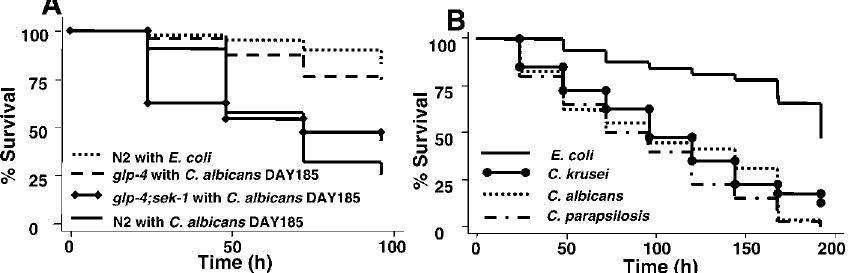
Figure 1. Killing of C. elegans after Exposure to Candida Species (A) N2, glp-4, or glp-4;sek-1 L4 nematodes feeding on E. coli OP50 were transferred to C. albicans strain DAY185 for 2 h and then transferred to pathogen- free liquid medium. Dead nematodes were counted and removed daily. N2 worms transferred from E. coli OP50 directly to liquid media were used as control. Survival of glp-4;sek-1 is significantly shorter compared to the strain glp-4 ( p , 0.001). (B) Survival of C. elegans glp-4;sek-1 feeding on lawns of C. albicans ATCC#90028, C. parapsilosis ATCC#20019, or C. krusei ATCC#6258. p , 0.001 for each of the yeast strains compared to control nematodes that were exposed to E. coli OP50 ( ; 65 nematodes/group).